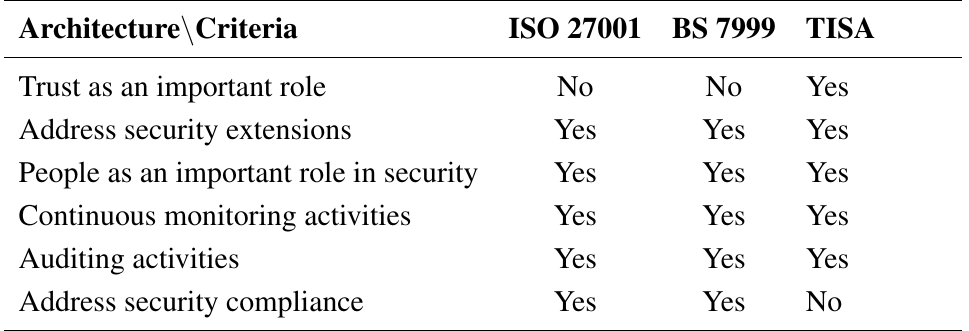
Table 1. Comparison